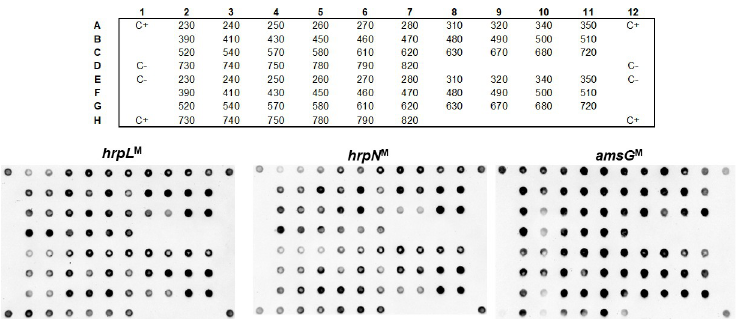
Fig 2. Dot blot results. Dot blot using three probes ( hrpL M , hrpN M and amsG M ) and genomic DNA from 36 Erwinia amylovora isolates. The top grid represents the position of the DNA from each E . amylovora isolate in the nylon membrane. Positive control (C+): Type Strain LMG 2024. Negative control (C-): TE Buffer.